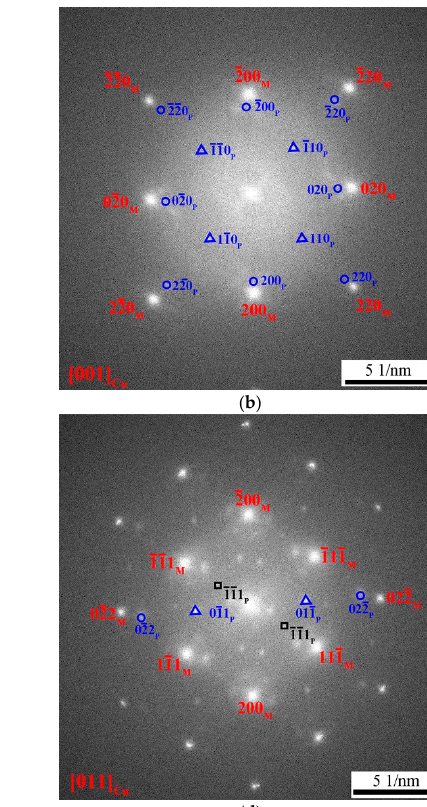
Figure 5. A high-magnification, longitudinal cross-section TEM observation of the aged Cu-0.4Cr- 0.4Hf-S2.